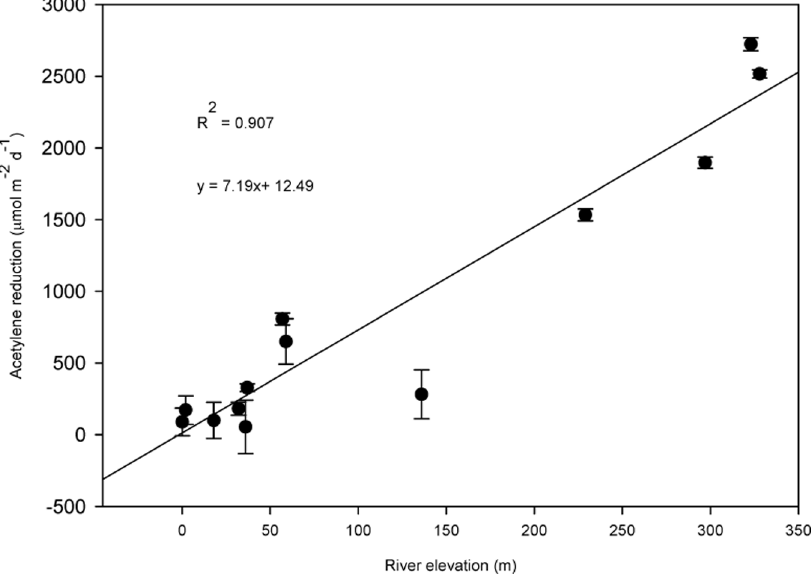
Figure 5. Nitrogenase activity in thirteen individual alluvial meadow sites at different river elevations along the Torne River in Northern Sweden. Lower river elevations are associated with more dense populations, increasing agricultural development and increasing wastewater of effluent from communities. Each data point represents the mean of seven sampling dates with samples collected during the summer of 2009 with 12 subsamples collected at each site on each sample date, bars represent one standard error (n=7).